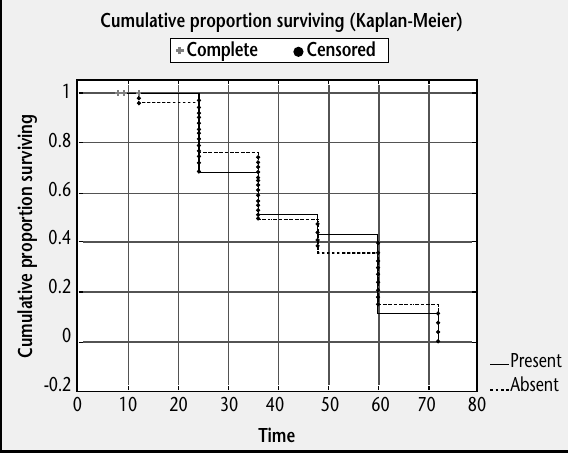
Figura 4 – Survival curve of Kaplan-Meier comparing the presence and absence of BRAF mutations ( p = 0.93)